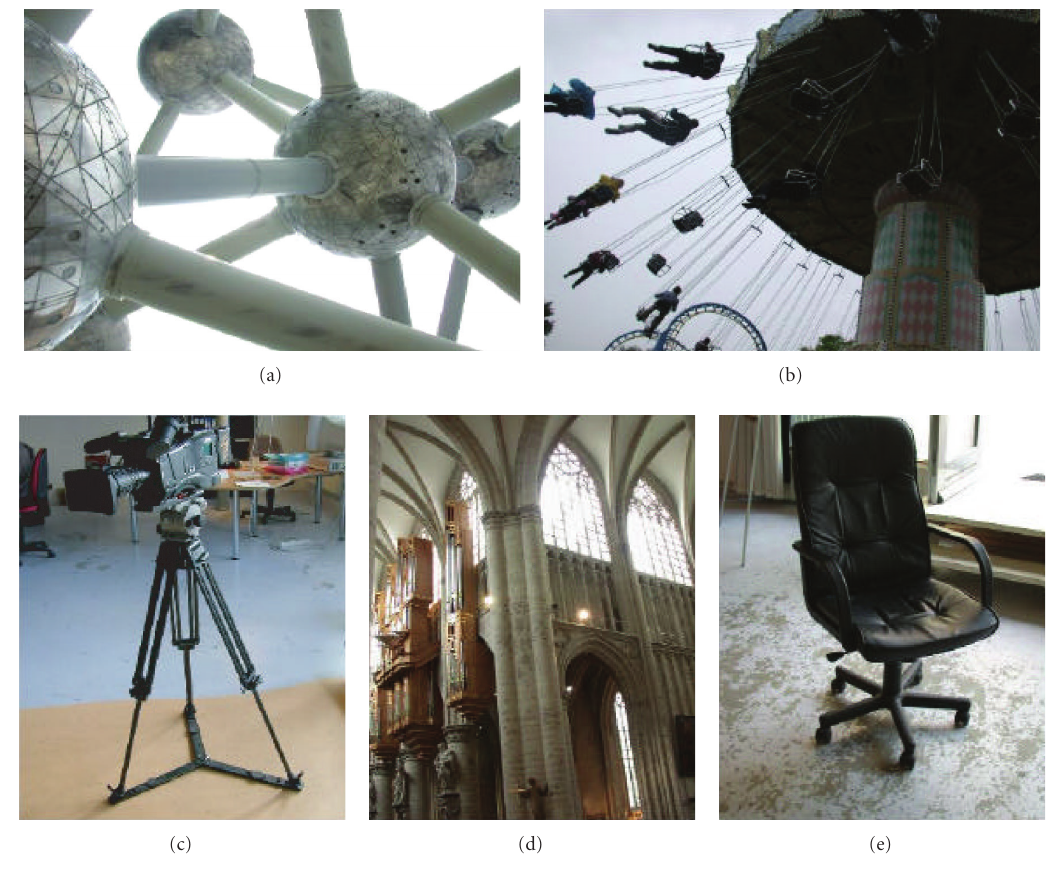
Figure 1: Some “SLAT” images used in the